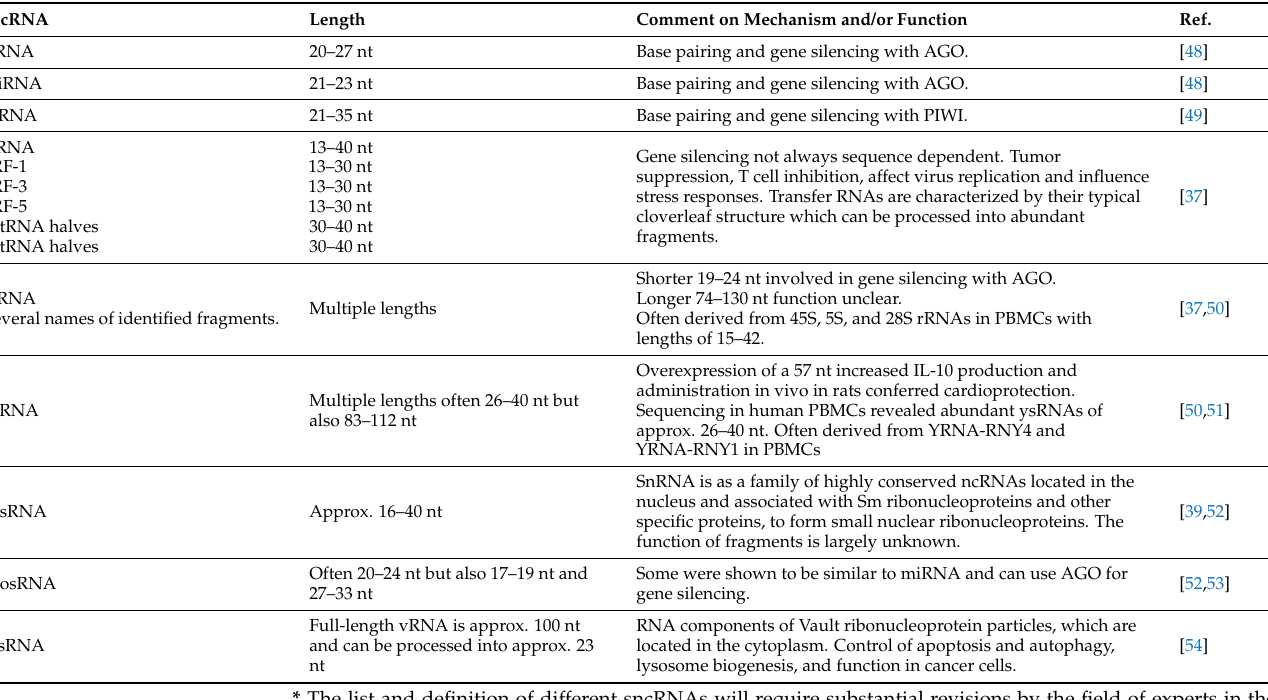
Table 2. Brief description * of different types of sncRNA.